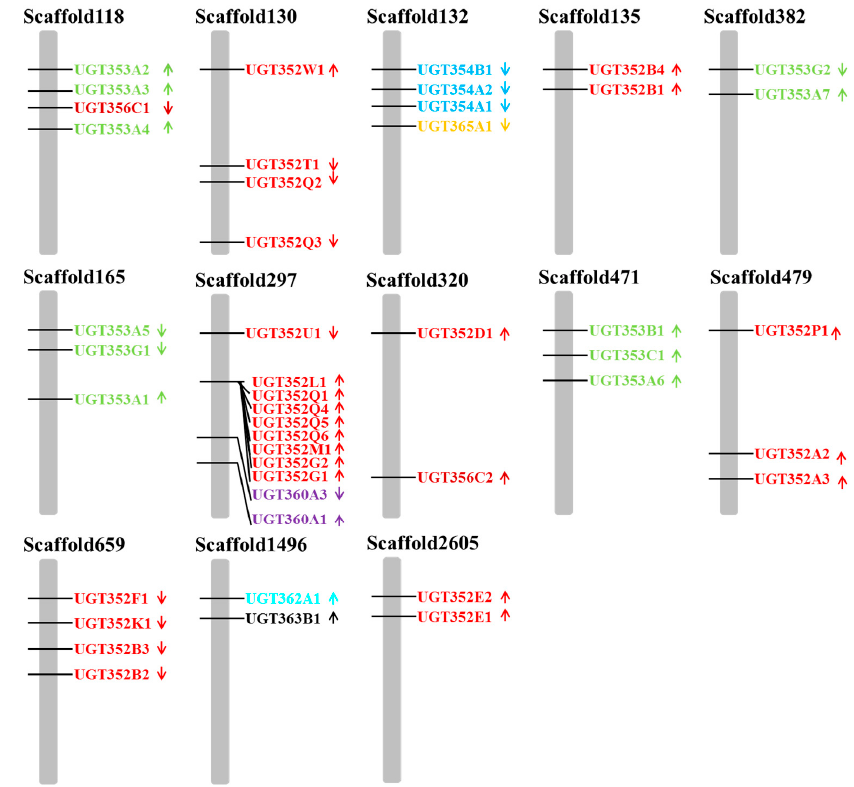
Figure 1. The relative physical positions of UGT genes on scaffolds of the B. tabaci MEAM1 genome. Arrows indicate the transcription direction of UGTs and genes in the same color belong to the same gene family. Accession numbers of UGT protein sequences used are listed in Table S1. Only sca ff olds with more than 2 UGTs are shown in this